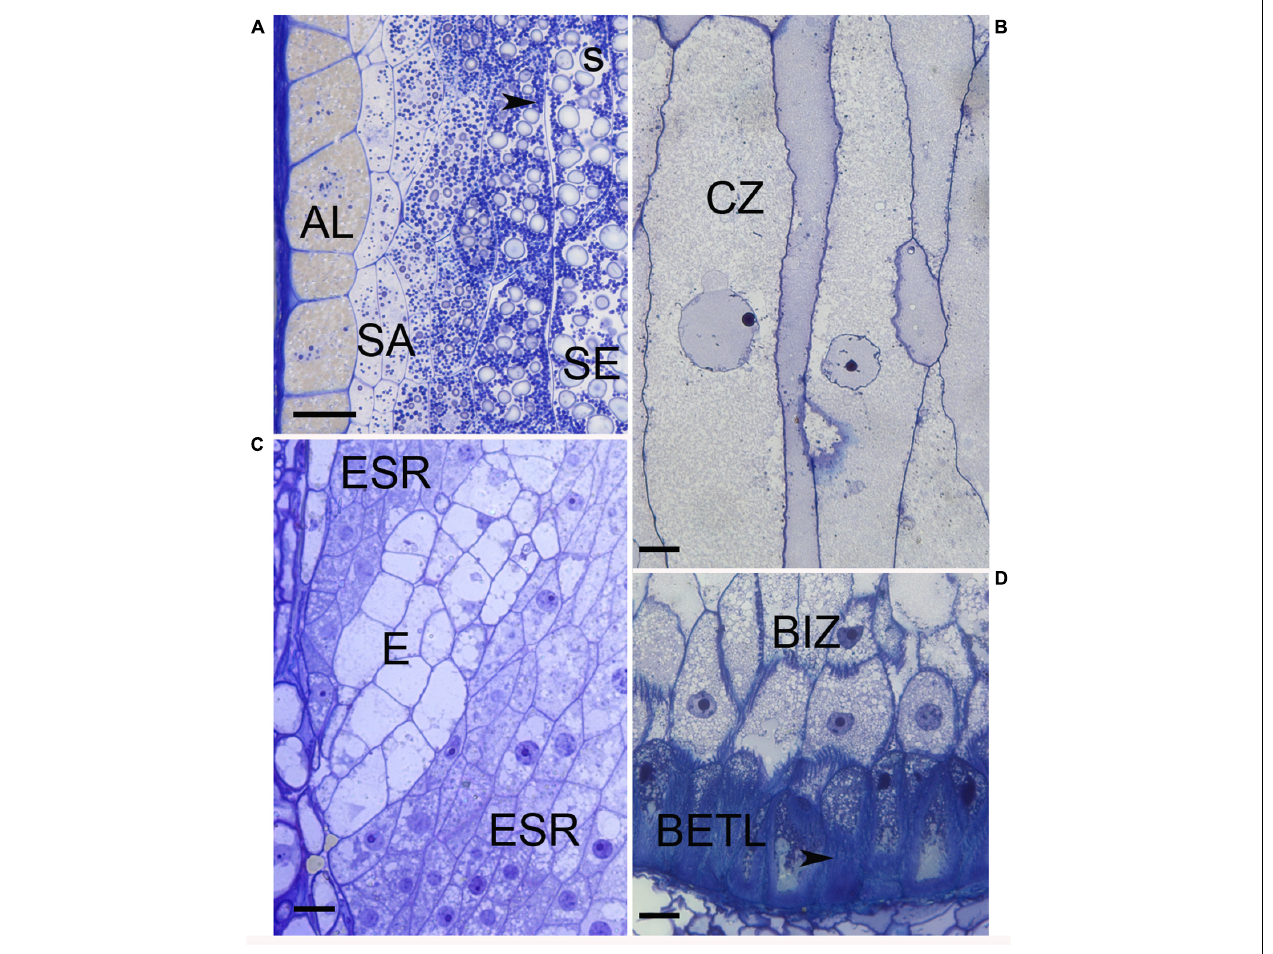
FIGURE 2 | Light micrographs of maize cell types. (A) Edge of 20 DAP endosperm with aleurone (AL), subaleurone (SA), and starchy endosperm (SE). Within the SE abundant starch (s) and protein bodies (arrowhead) are present. (B) Conducting zone cells when first apparent, about 10 DAP. (C) Embryo surrounding region (ESR) cells at 8 DAP are restricted to surrounding the embryo suspensor (E). (D) Base of endosperm at 10 DAP when BETL cells have developed wall ingrowths (arrowhead) and adjacent basal intermediate zone cells (BIZ) are visible. Bars = 20 µ m.